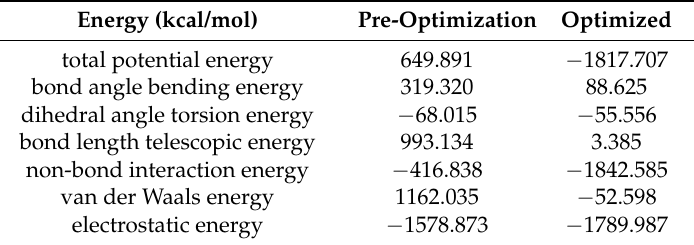
Table 1. Molecular energies before and after optimization.